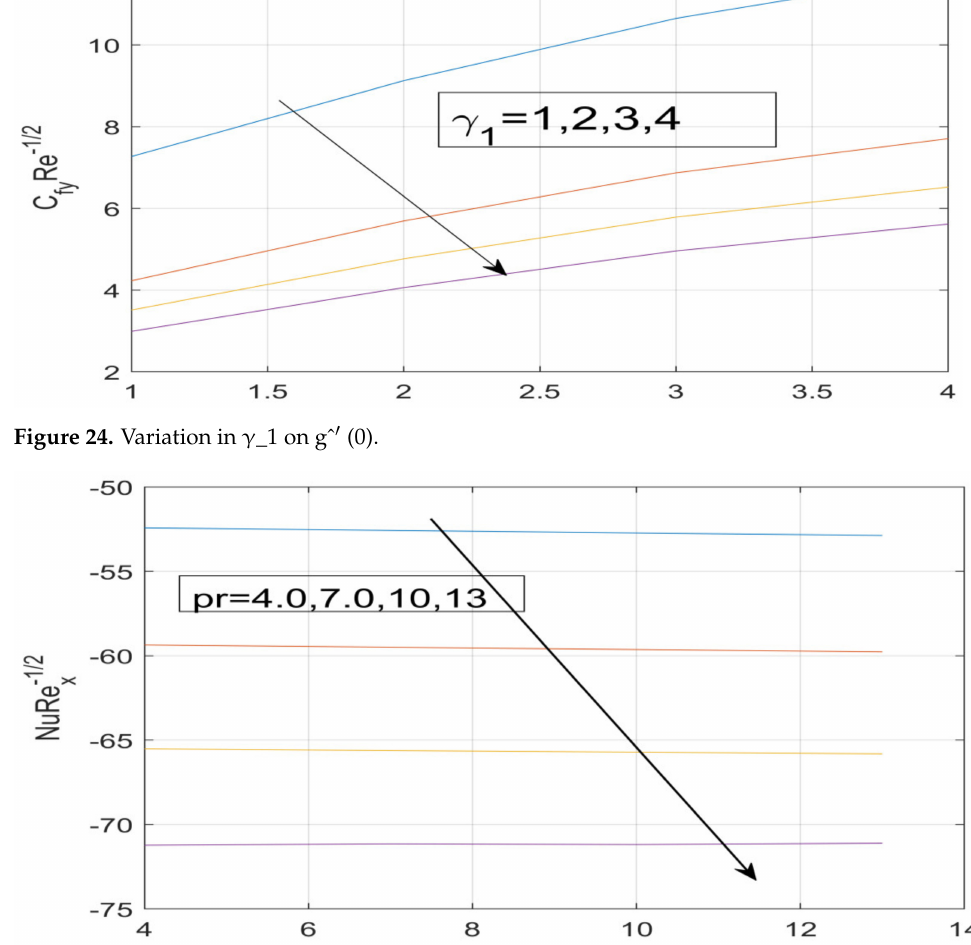
Figure 25. Effect of Pr on − θ ˆ (cid:48)